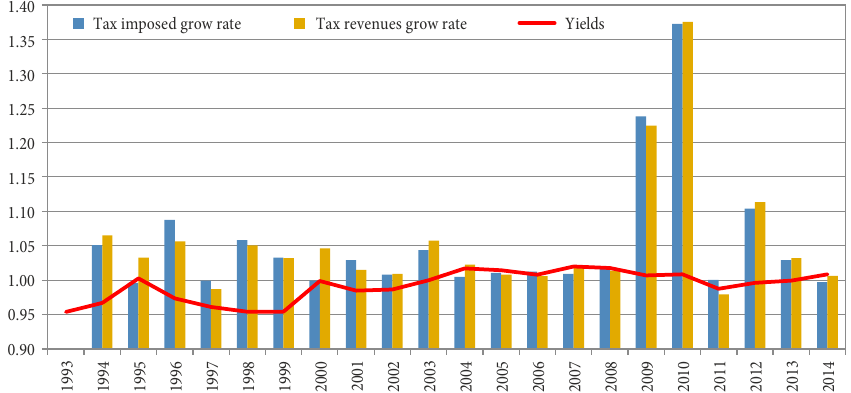
Fig. 3. Use of the local coefficient by municipalities between 2009 and 2014 Source: Tax administration 2015, own processing